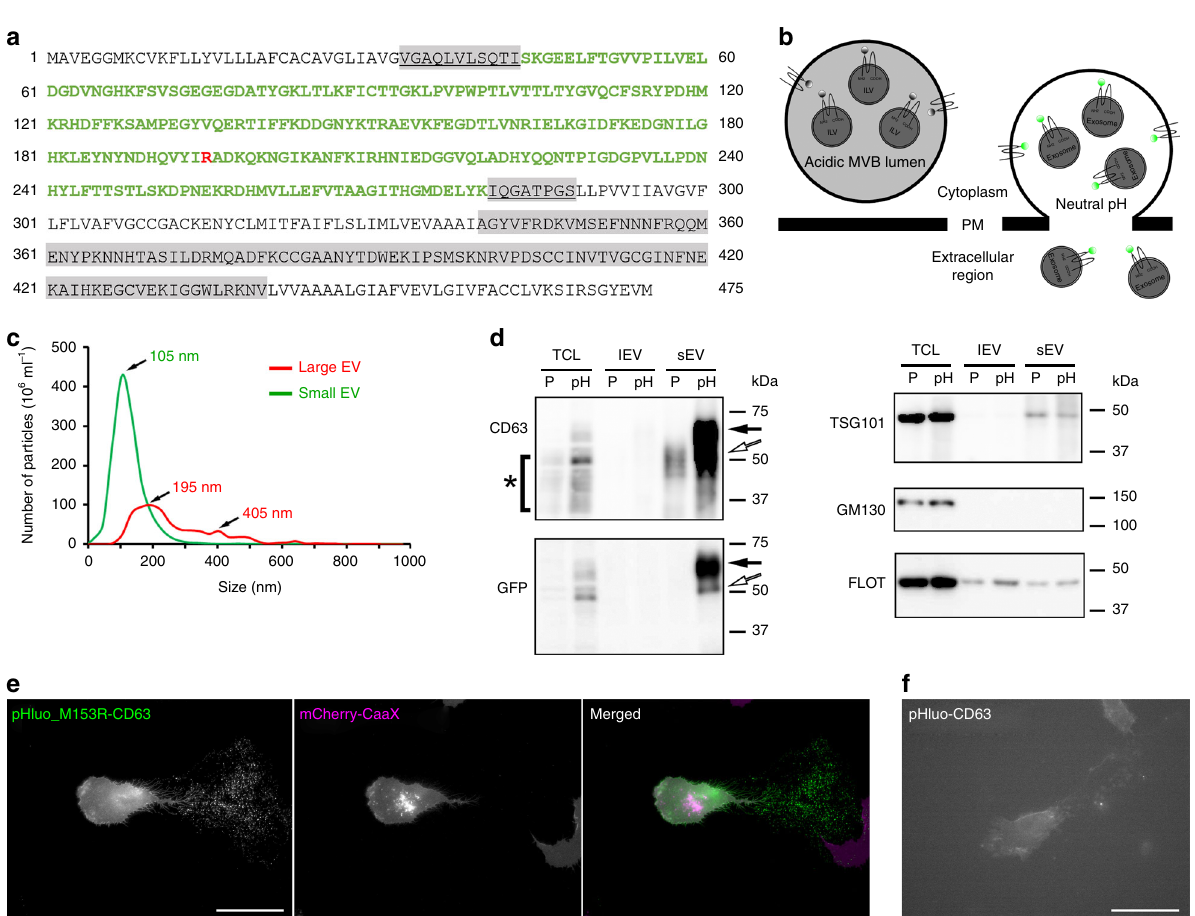
Fig. 1 pHluo_M153R-CD63 is a bright, stable exosome reporter. a Sequence of pHluo_M153R-CD63. pHluorin sequence is in green color. Highlighted regions in gray represent small (underlined) and large extracellular loops. M153R mutation is marked in red. b Diagram of pHluo_M153R-CD63 construct. Notice pHluo_M153R tag has bright fl uorescence upon fusion of the multivesicular body (MVB) with the plasma membrane due to the exposure to neutral pH. Otherwise, it is non fl uorescent in the acidic condition of the MVB lumen. ILV intraluminal vesicle, PM plasma membrane. c Representative trace from nanoparticle tracking analysis of large EVs and small EVs. d Western blot analysis of cells and EVs with anti-CD63, anti-GFP, EV markers (TSG101, Flotillin) and Golgi marker (GM130). TCL total cell lysate, lEV large EV, sEV small EV, P parental cells, pH pHluo_M153R-CD63-expressing cells. Black arrows indicate full-length pHluo_M153R-tagged CD63, which is shifted due to the GFP moiety of 27 kDa, while white arrows indicate potential cleaved form of CD63 tagged with pHluo_M153R. Asterisk (*) indicates cellular CD63, which has a broad range due to glycosylation. e Still images from Supplementary Movie 1 (upper panel) showing a migrating HT1080 cell stably expressing mCherry-CaaX (magenta) and pHluo_M153R-CD63 (green). Colocalization of magenta and green is white. Notice that the deposits left behind the migrating cell are only labeled with CD63 not with CaaX. Scale bar, 50 µ m. Movie representative of 38 movies. f Still images from Supplementary Movie 1 (lower panel) showing a migrating HT1080 cell transiently expressing pHluo- CD63. Scale bar, 50 µ m. Movie representative of 12 movies. Source data are provided as a Source Data fi